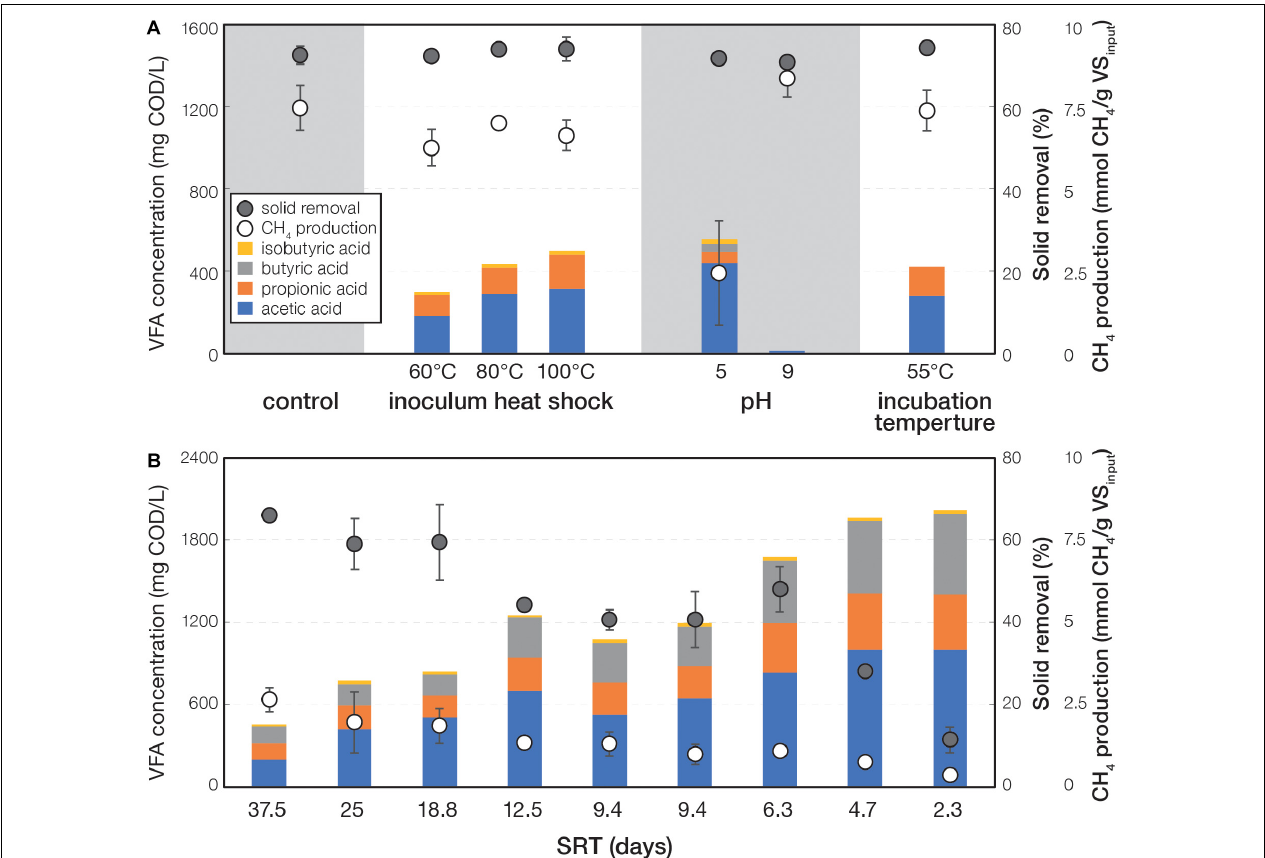
FIGURE 1 | VFA concentration, CH 4 production, and solid removal of (A) experiment I at day 24 and (B) experiment II at day 18.